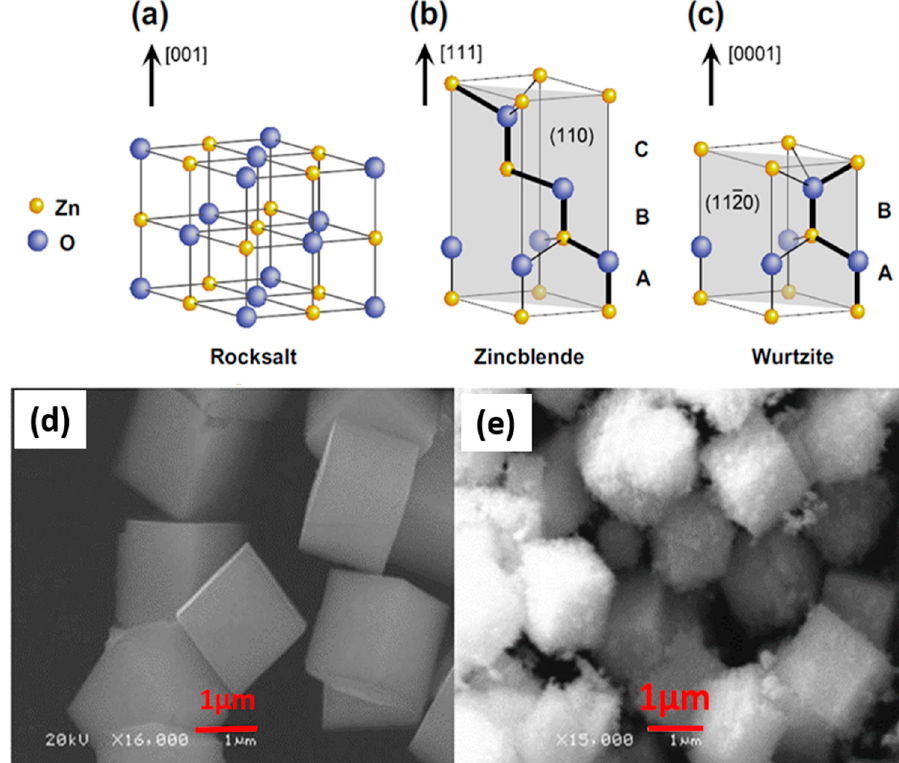
Figure 7. (a)Rock salt, (b) Zincblende, (c) Wurtzite crystal structure and (d-e) 3 D Cubic morphological structures of ZnO nanoparticles [6,